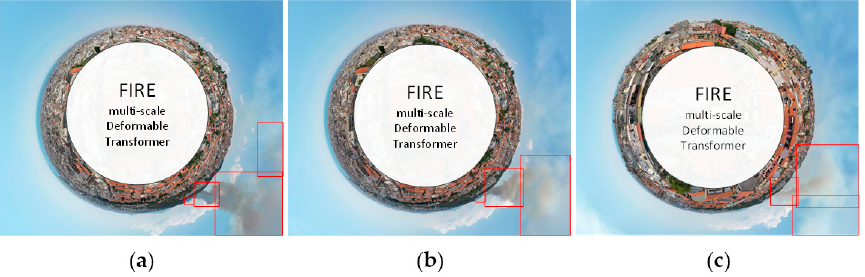
Figure 11. Fire detection (red boxes) of the FIRE-multiscale deformable transformer applied to 360-degree stereographic projections at three different time points ( a – c ) of the fire event.